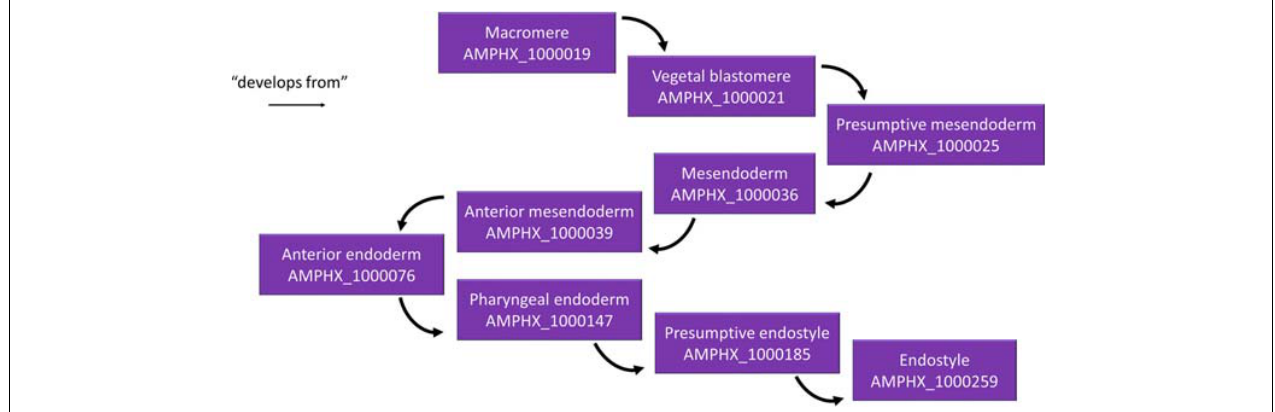
FIGURE 4 | Example for the hierarchical relationships in the AMPHX ontology. Using the amphioxus endostyle as an example, the anatomical entities giving rise to the structure (“develops from”) are indicated, starting with the macromere in the 8-cell stage embryo. The figure has been adapted from the Graph view utility proposed at OLS (Côté et al.,